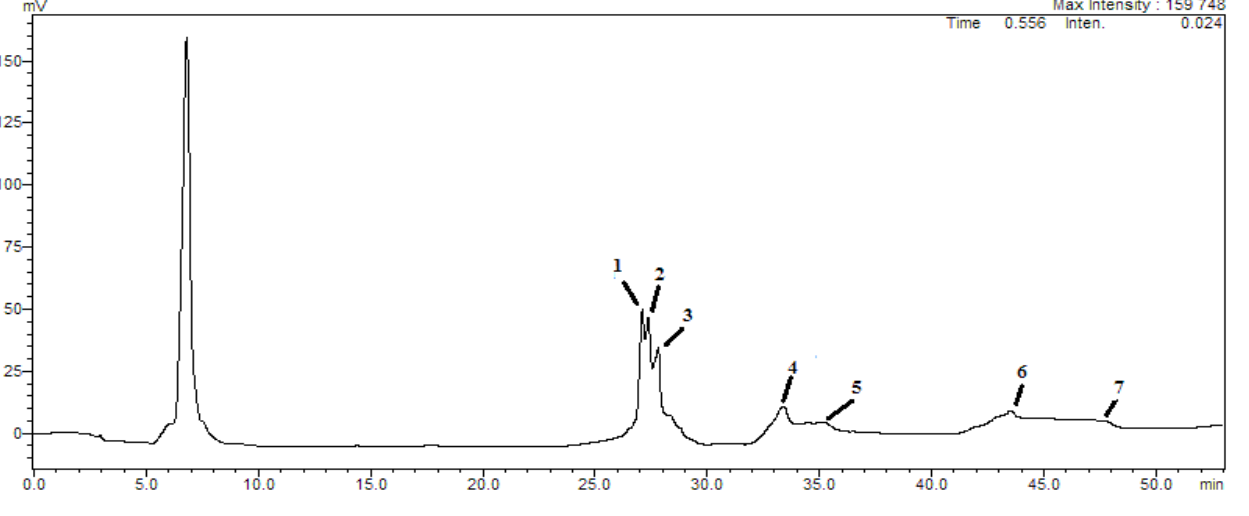
Figure 1. Liquid chromatographic HPLC analysis of RWA. Table 1. Chemical compounds identified by HPLC analysis of